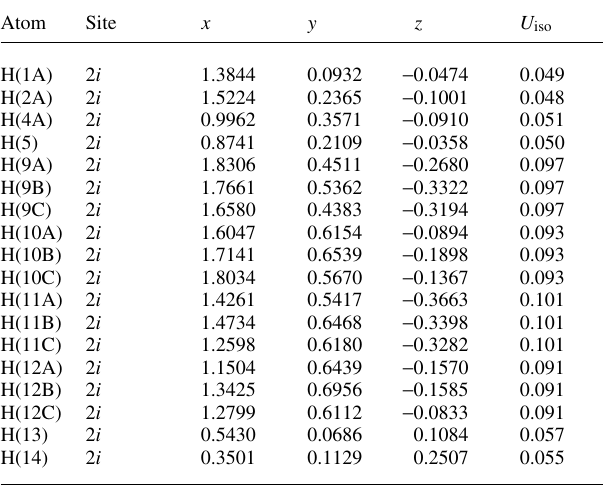
Table 2. Atomic coordinates and displacement parameters (in Å 2 )